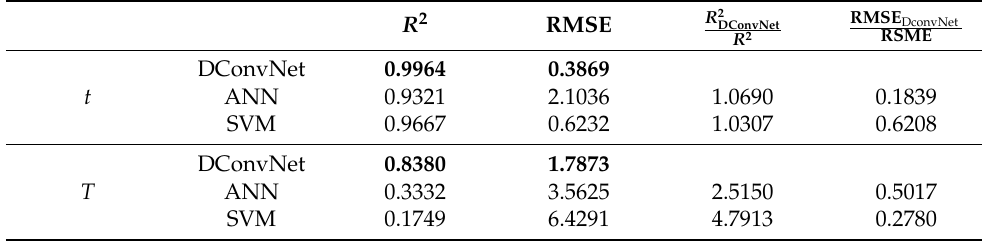
Table 2. Performance